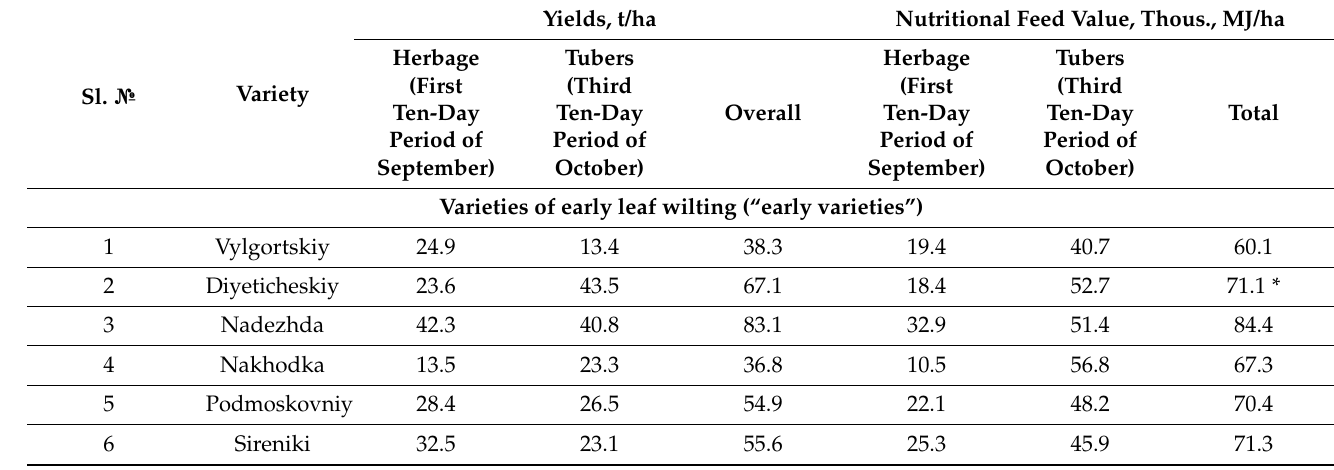
various Jerusalem artichoke varieties grown on sod-podzolic sandy loam soils under the conditions of the “Korenevo” Experimental Center, Lyuberetskiy District, Moscow Region, is shown Table 3 and Figure 3. Table 3. Gross productivity of Jerusalem artichoke (green weight for foliage + tubers), (2014 – 2016).